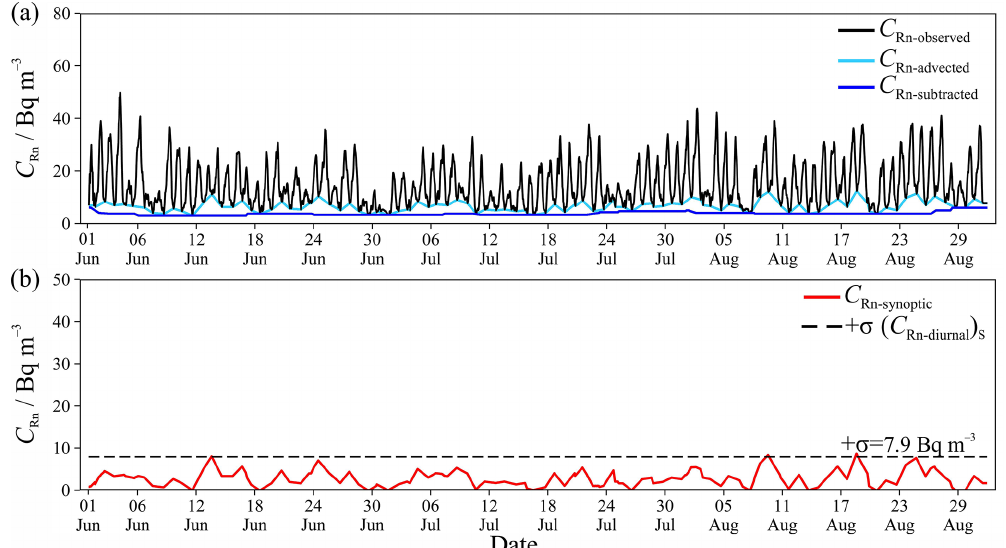
Figure 8. (a) Hourly mean observed radon concentrations, the advected radon contribution with subtracted radon indicated, and (b) isolated synoptic timescale radon contribution in summer with the standard deviation ( + σ ) of the diurnal contribution indicated. No persistent temperature inversion events were detected by the RBM this